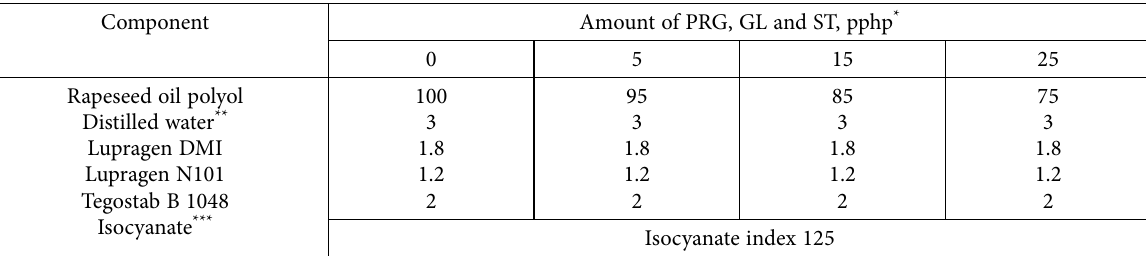
Table 1. The composition of rigid PU foam